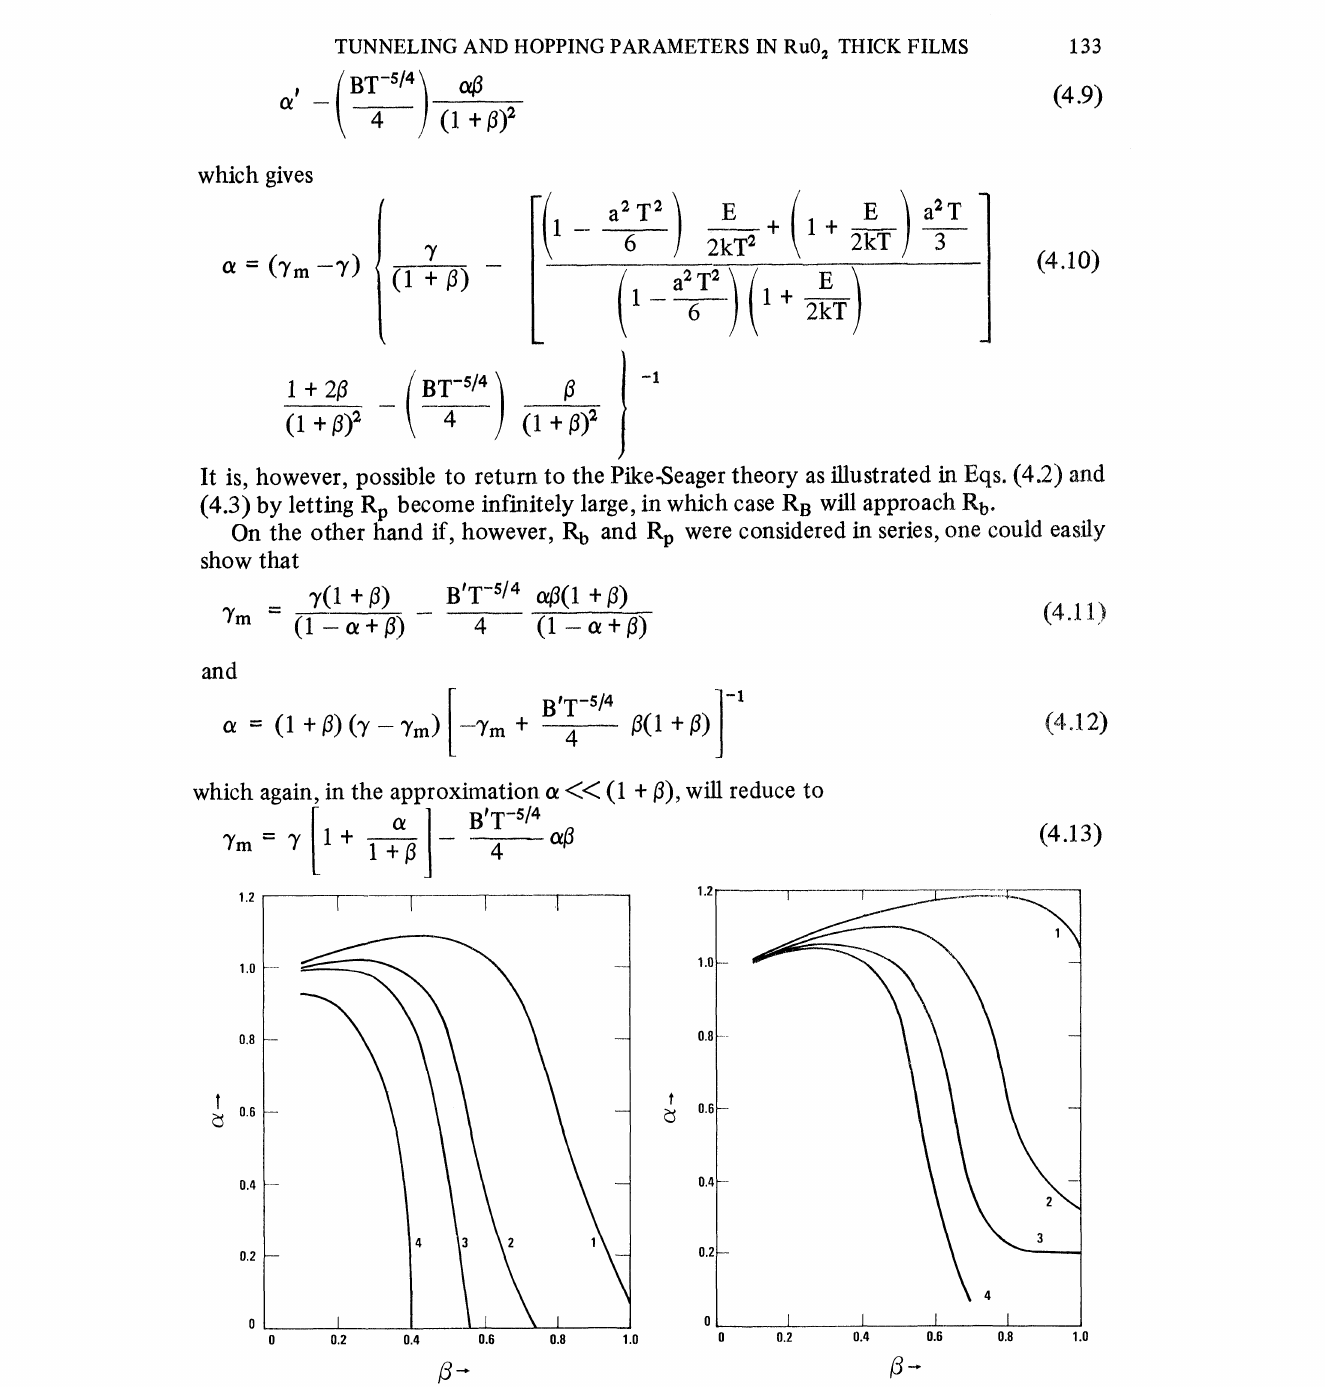
The plots of a against/ for films in 3a2. Curve 1" 70C; curve 2: 80C; curve 3" 90C; and curve 4" 100C. (a) The parallel mode, as shown in (a), was obtained with Eq. 4.7) (b) The series mode, as shown in (b), was obtained with Eq.